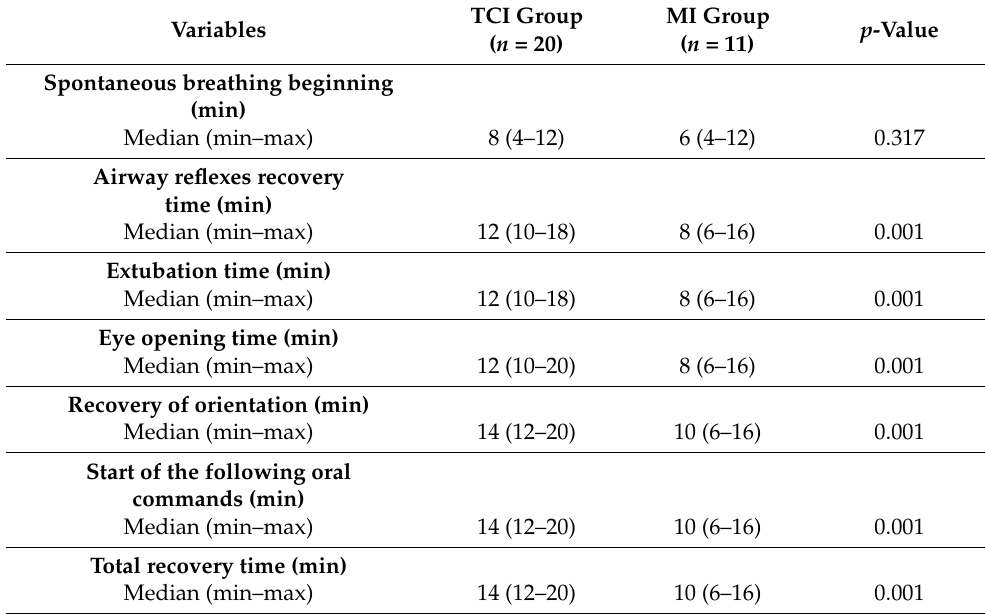
Figure 2. Remifentanil consumption, p = 0.02. Table 3. Intraoperative and immediate postoperative